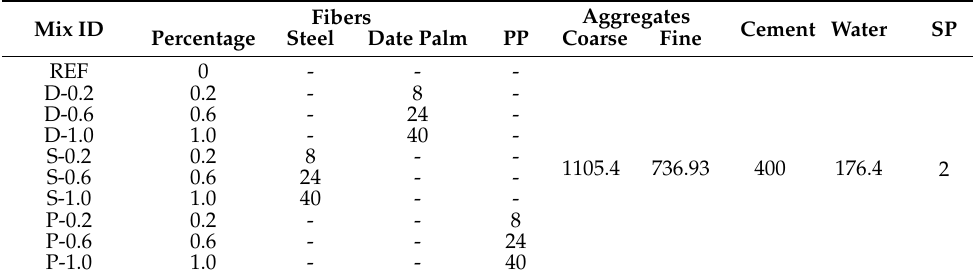
Table 6. High-strength fibrous concrete mixtures (kg/m 3